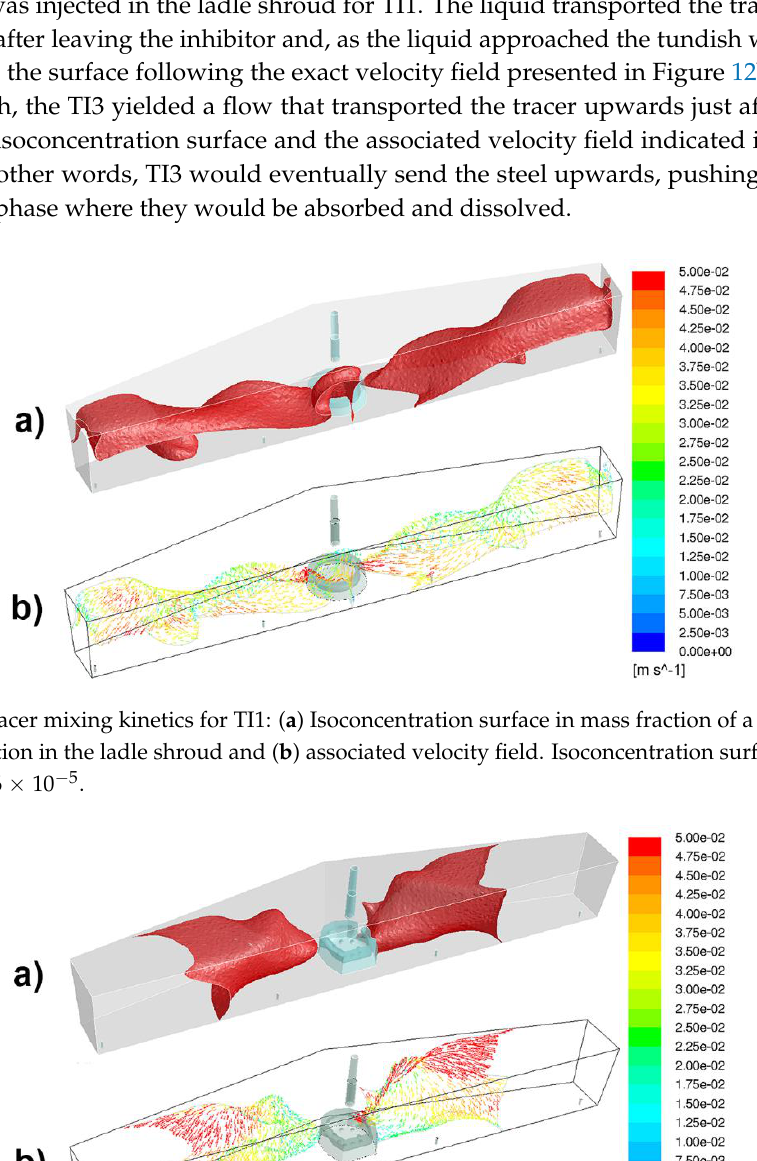
Figure 14. Experimental and numerical RTD curves: ( a ) Internal strand, TI1; ( b ) External strand TI1; ( c ) Internal strand, TI3; and ( d ) External strand, TI3. 4. Conclusions •